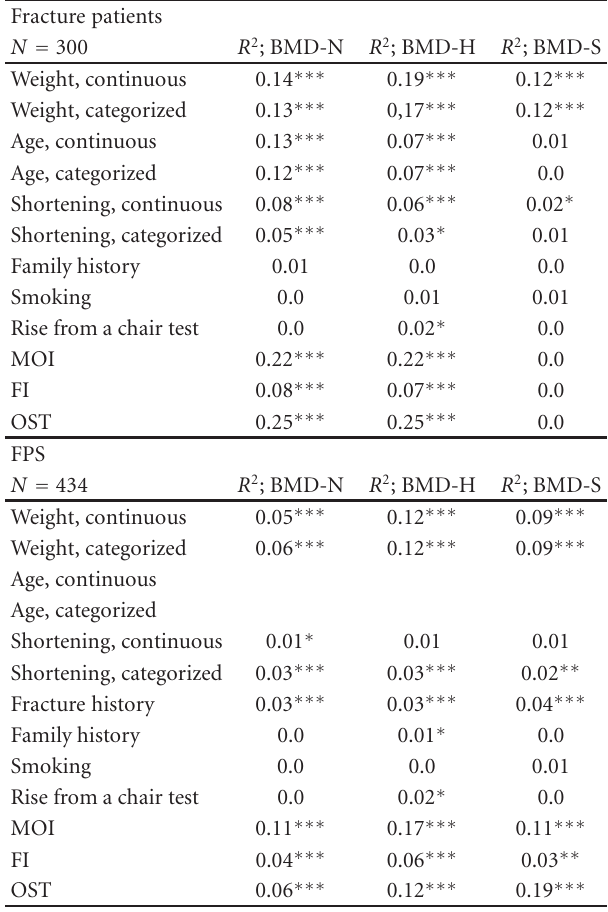
Table 2: Proportion of variance in BMD in Development Cohort 1 (fracture patients, N = 300, age 45–79) and Development Cohort 2 (FPS, N = 434, age 65–72). R 2 value (%), explained by the risk factors in univariate regression models, and by MOI, FI, and OST- scores.